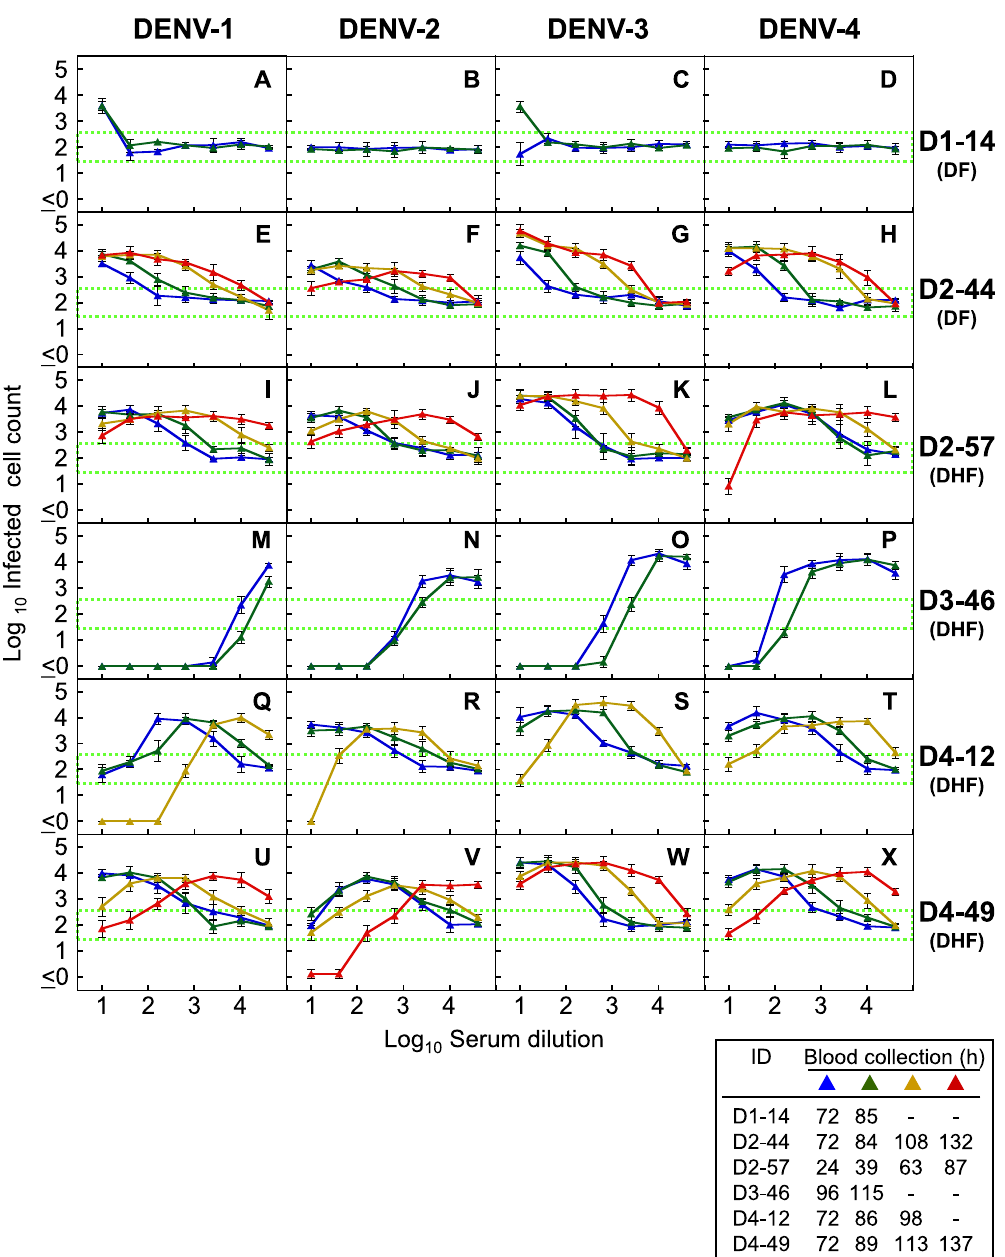
Figure 2. Balance between neutralizing and enhancing activities against four prototype viruses. The NAb/EAb- balance assay was performed with a combination of serum (D1-14: A – D , D2-44: E – H , D2-57: I – L , D3-46: M – P , D4-12: Q – T and D4-49: U – X ) and four prototype viruses (DENV-1: Mochizuki strain; DENV-2: NGC strain; DENV-3: H87 strain; and DENV-4: H241 strain). The blue , green , yellow and red triangles, corresponding to Fig. 1A, indicate the hours after fever onset. The abscissa indicates the serum dilutions and the ordinate shows the numbers of infected cells (both expressed as log10). Each data point represents the average of two separate assays; error bars indicate the SDs. Dotted lines indicate the mean numbers of infected cells plus or minus three times the SD (mean ± 3SD), to define neutralizing or enhancing activity,